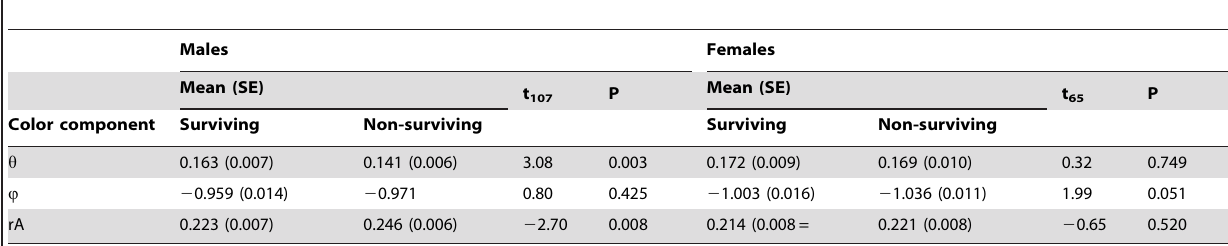
Table 1. Mean (SE) tetrahedral color component values of males or females that did or did not survive.